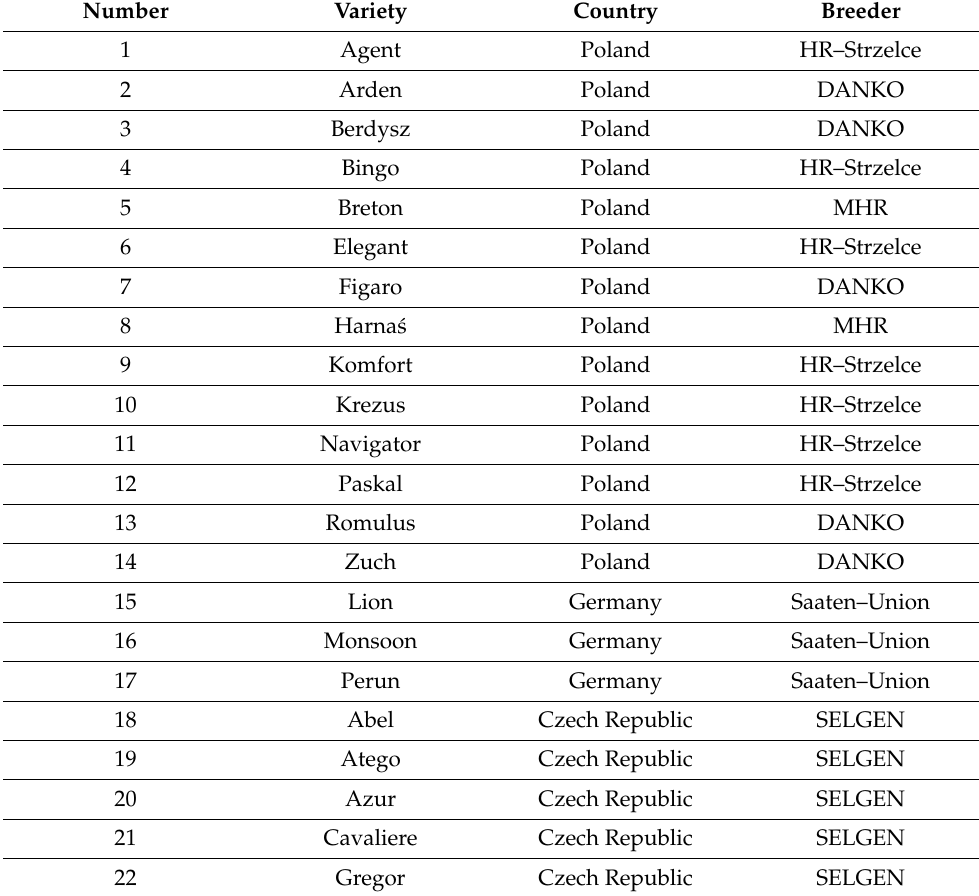
Table 1. 36 A. sativa L. cultivars currently cultivated in Central